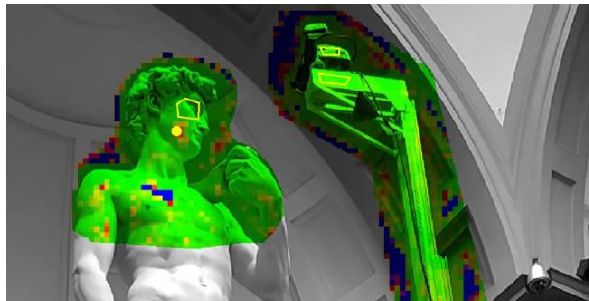
Figure 5: Reference area on the statue and gantry’s top for deformation analysis: Overall view.